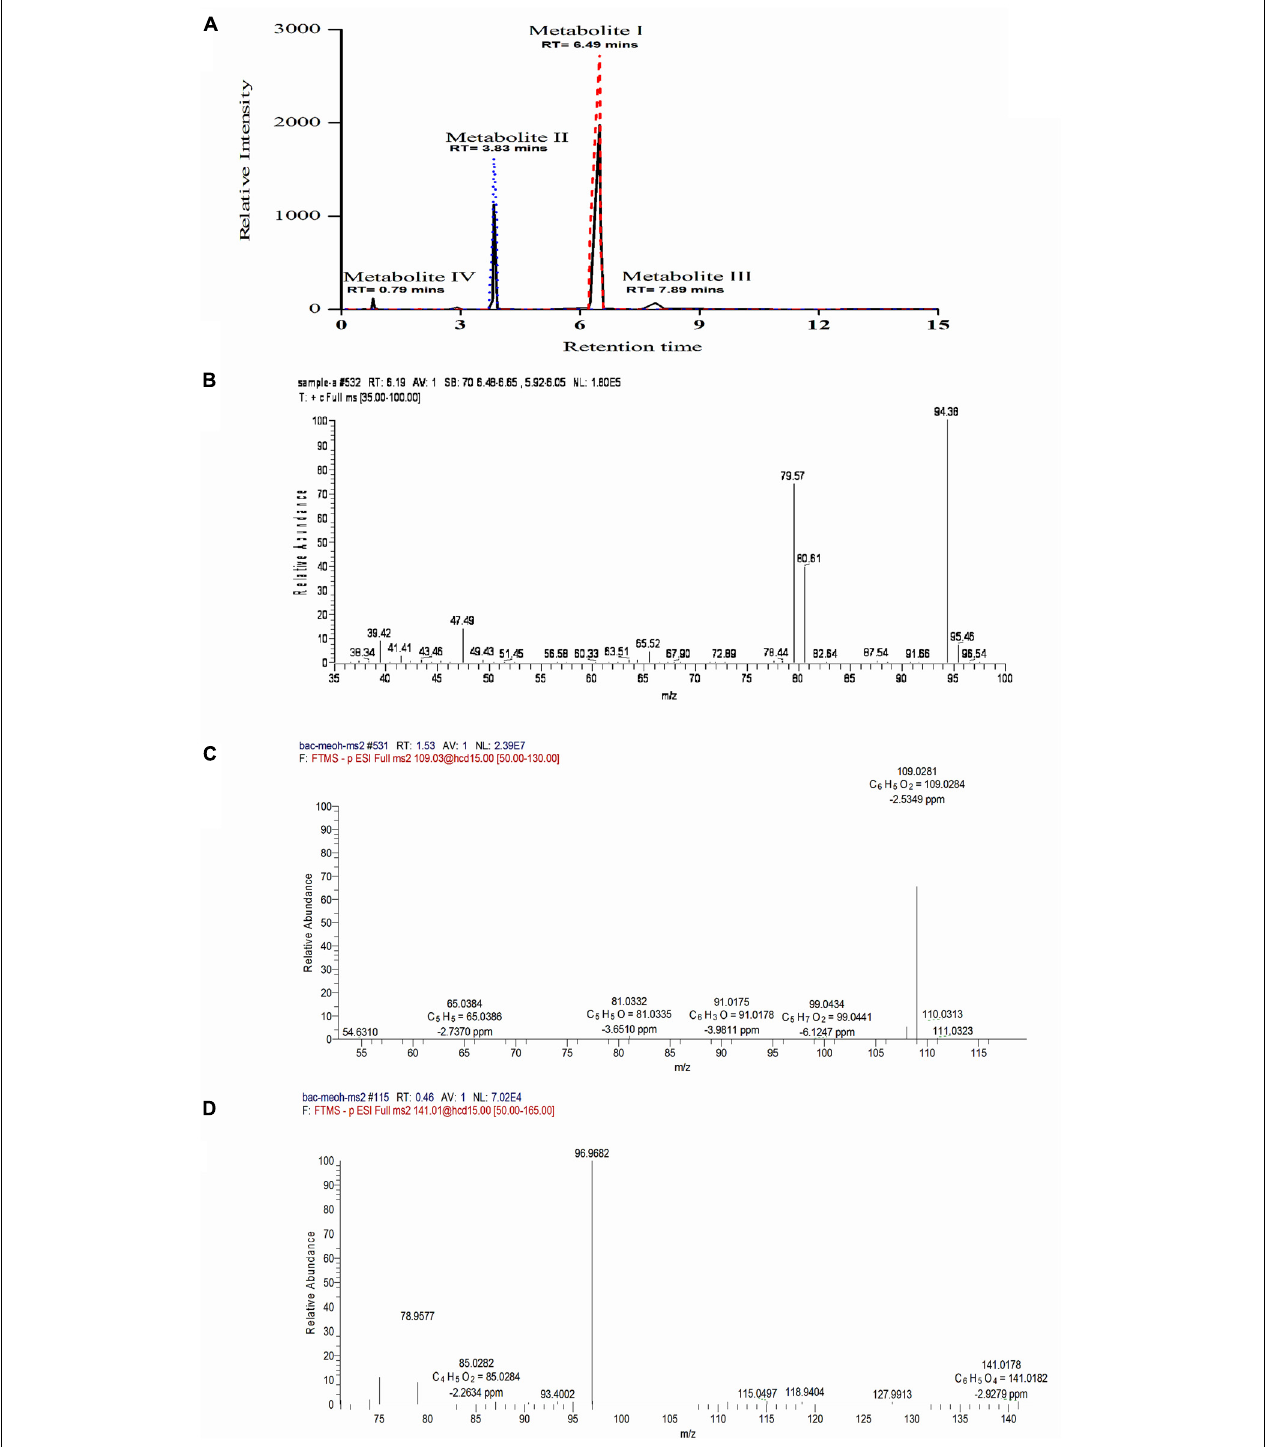
FIGURE 4 | Chromatographic and mass spectrophotometric analysis of the culture supernatant of Y. lipolytica NCIM 3589 after growth on bromobenzene. (A) HPLC profile of the culture broth extracts ( — ) showing co-elution with the standards, where ( ··· ) indicates the standard phenol and ( ··· ) indicates the standard catechol. Metabolite I and II co-eluted with the standard phenol and catechol respectively. (B) GCMS spectra for Metabolite I. (C) LCMS spectra for Metabolite II. (D) LCMS profile for Metabolite IV.